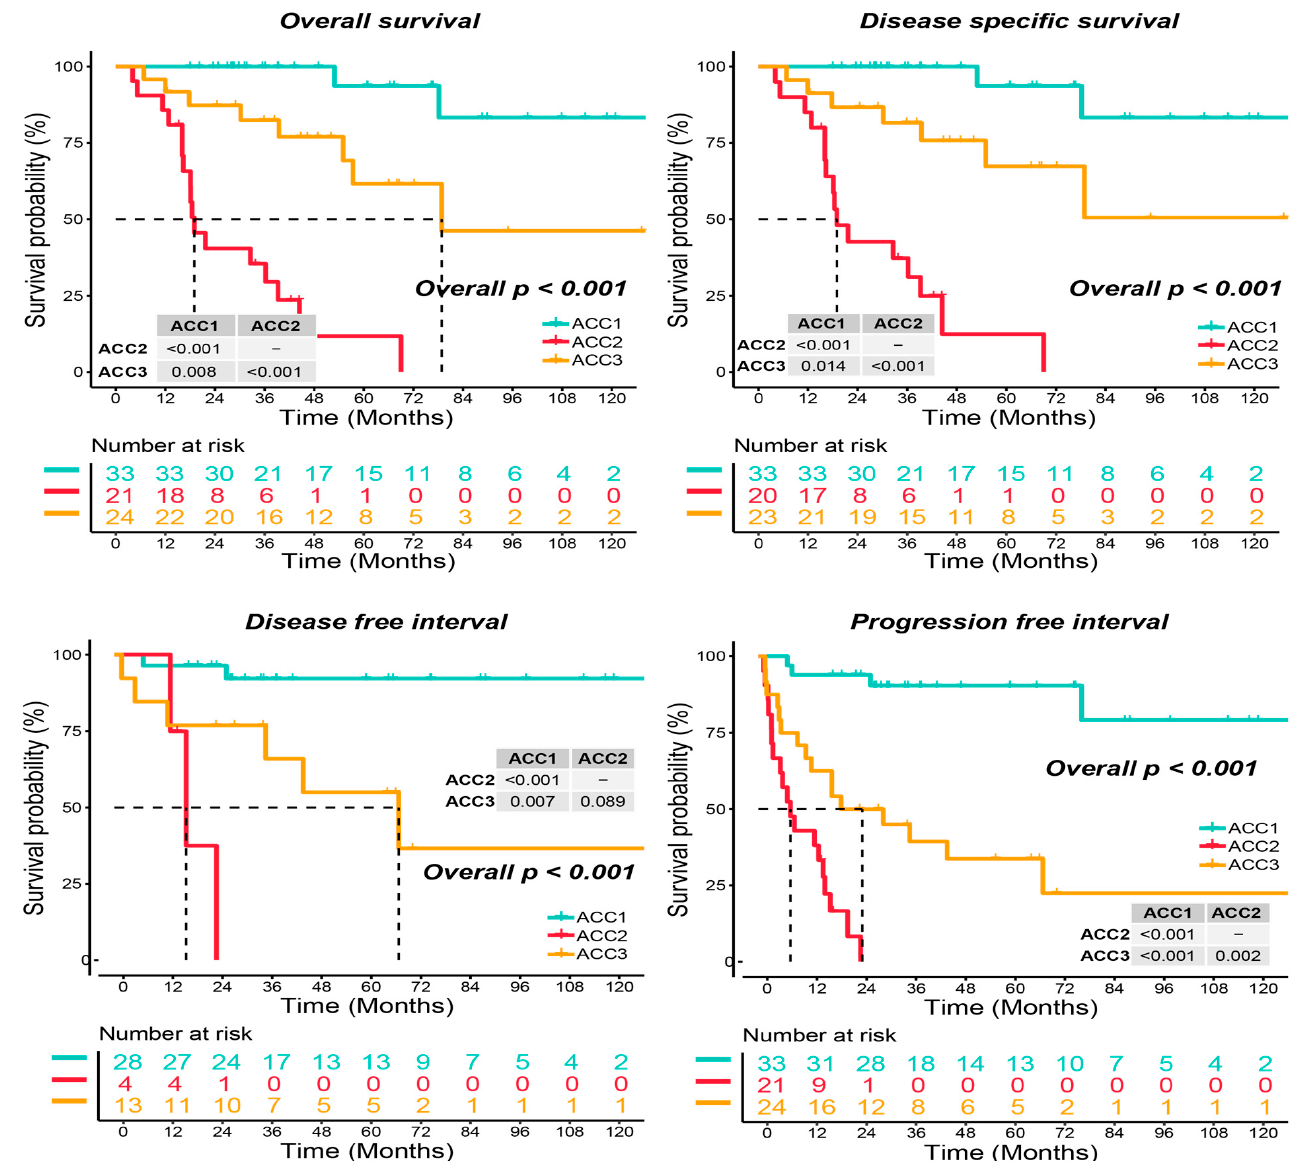
Figure 2. Differential survival outcome in three ACC subtypes, log ‐ rank test.